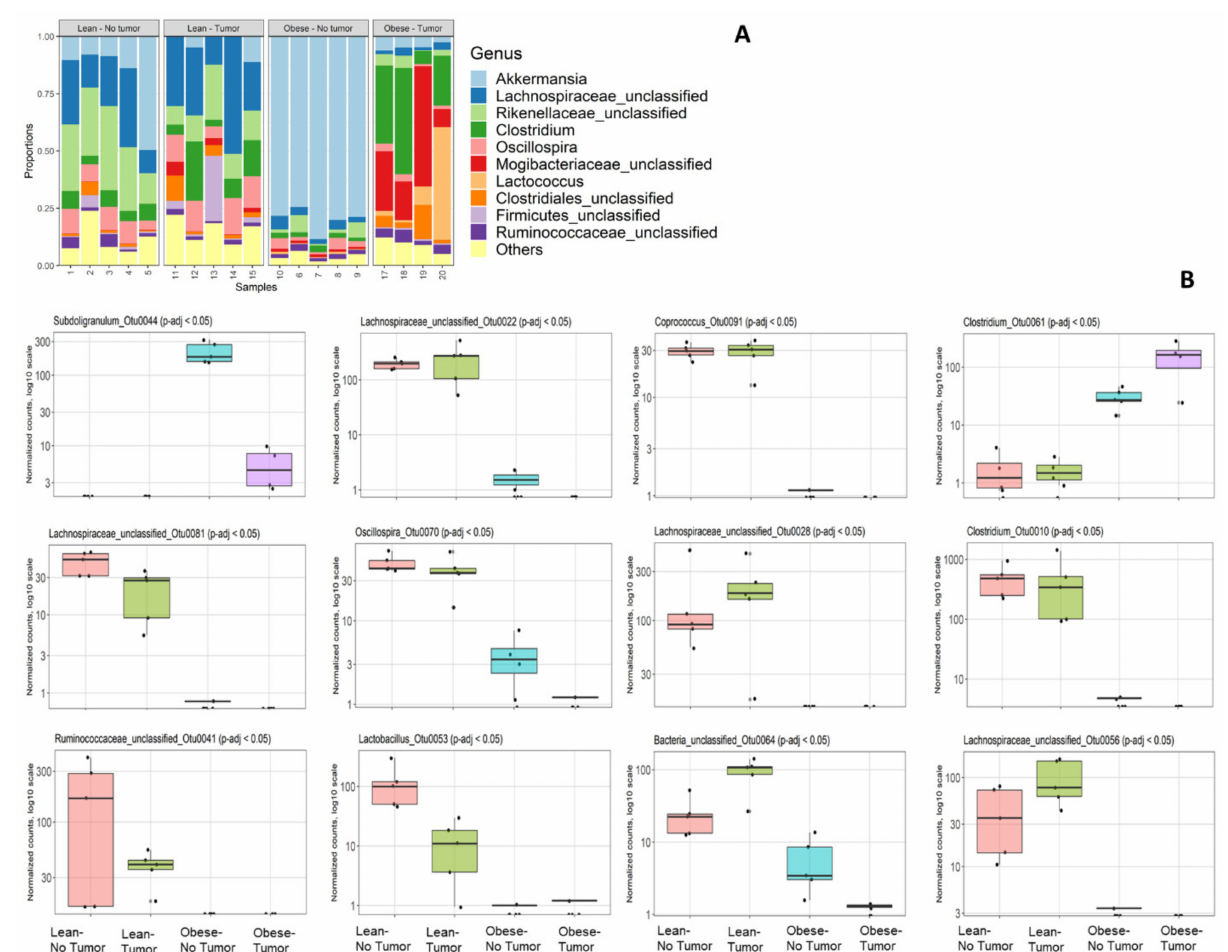
Figure 1. ( A ) Community composition by 16S rRNA sequencing. ( A ) Relative abundances of the most abundant taxa; ( B ) differential abundance testing: top 12 differentially abundant OTUs, sorted by q-value. In each plot, groups left to right are lean no tumor; lean–tumor; obese–no tumor;